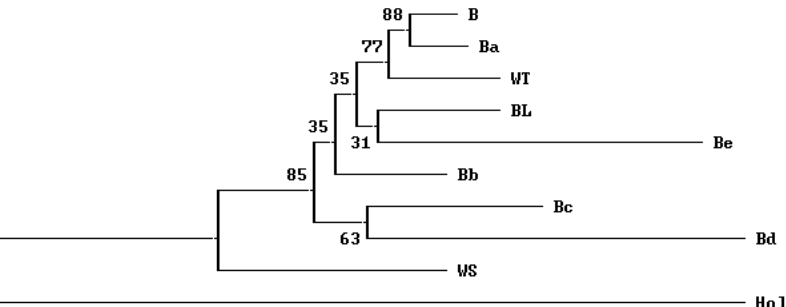
Figure 2. Neighbor-joining (NJ) tree showing the genetic relationships among the Hanwoo cattle using D A genetic distances based on 22 microsatellite loci. The numbers on the nodes are percentage bootstrap values for 1,000